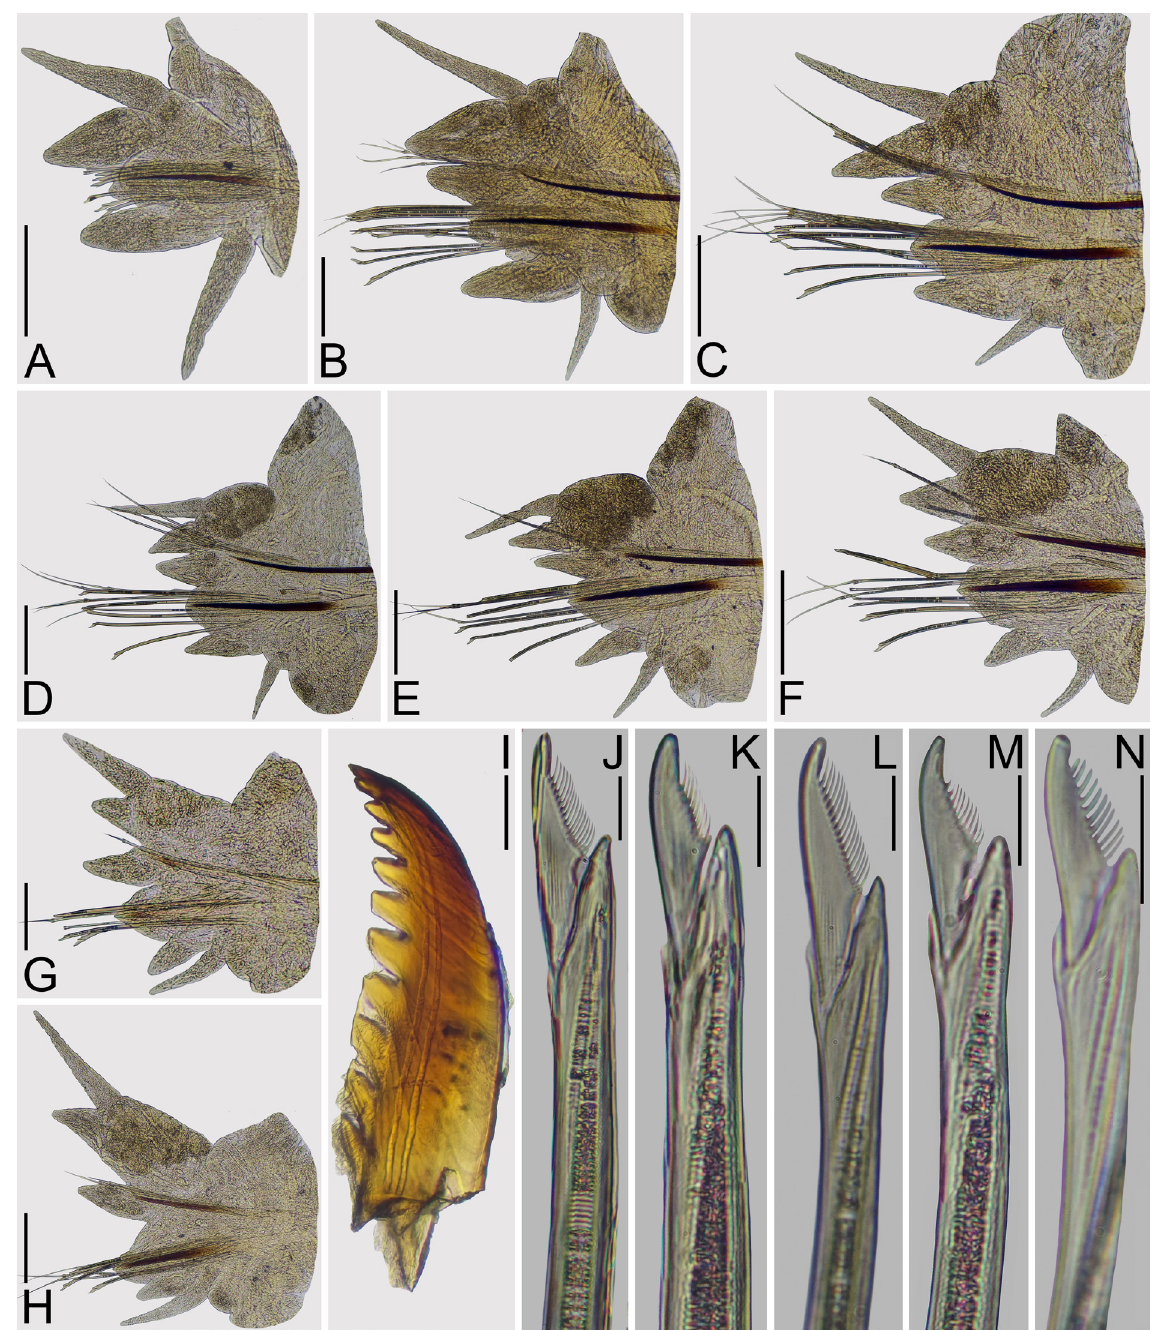
Fig. 9. Perinereis websteri sp. nov. A–G, I–N . Holotype (USNM 1490807). H . Paratype (USNM 1490809). A . Chaetiger 2, right parapodium. B . Chaetiger 10, right parapodium. C . Chaetiger 31, right parapodium. D . Chaetiger 50, right parapodium. E . Chaetiger 70, right parapodium. F . Chaetiger 75, right parapodium. G . Chaetiger 82, right parapodium. H . Chaetiger 100, right parapodium. I . Right jaw, dorsal view. J . Supra-acicular heterogomph falciger, chaetiger 31. K . Supra-acicular heterogomph falciger, chaetiger 75. L . Sub-acicular heterogomph falciger, chaetiger 31. M . Sub-acicular heterogomph falciger, chaetiger 75. N . Sub-acicular heterogomph falciger, chaetiger 82. Scale bars: A–F, H = 0.2 mm; G, I = 0.1 mm; J–N = 10